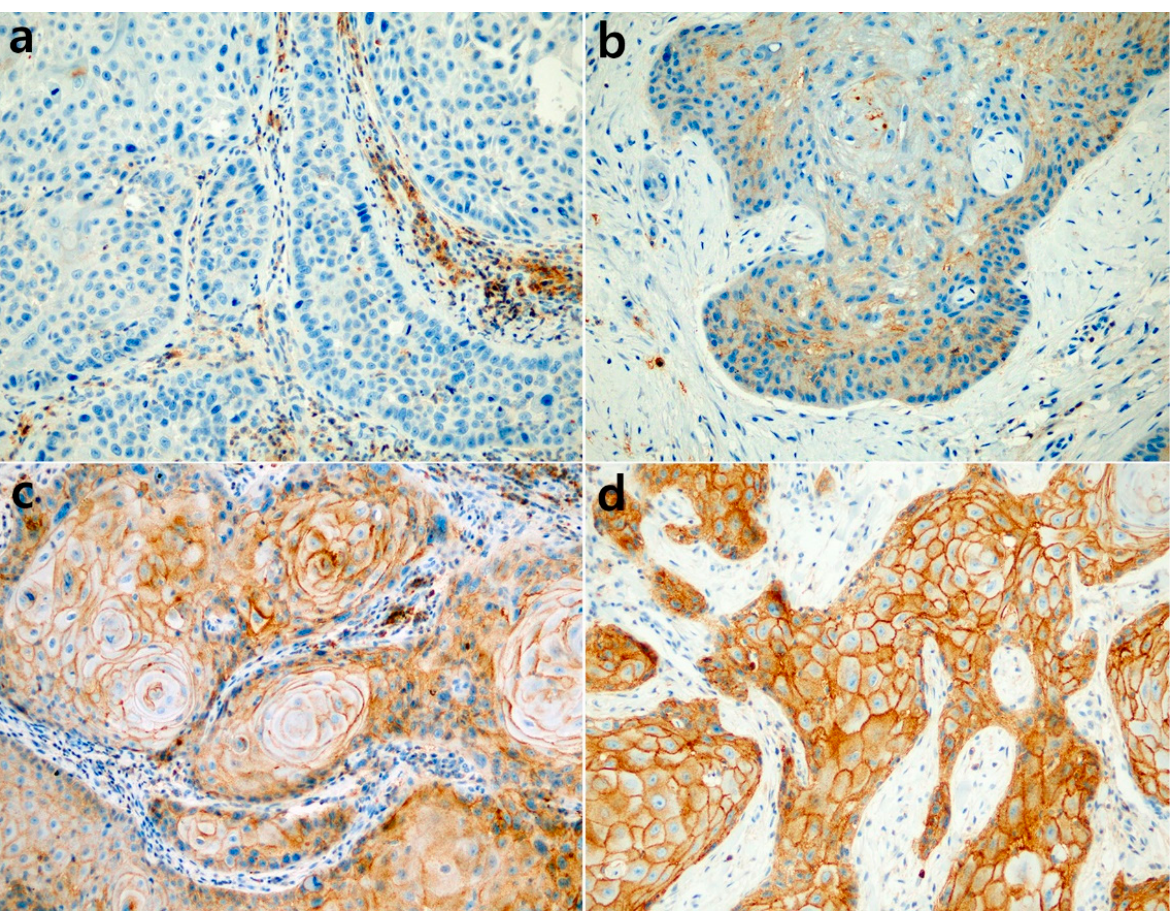
Figure 1. Representative photomicroscopic images of CD47 expression in squamous cell carcinoma. The staining intensity was classified as: ( a ) negative, 0; ( b ) weak, 1; ( c ) moderate, 2; and ( d ) strong, 3 ( a – d , x200).